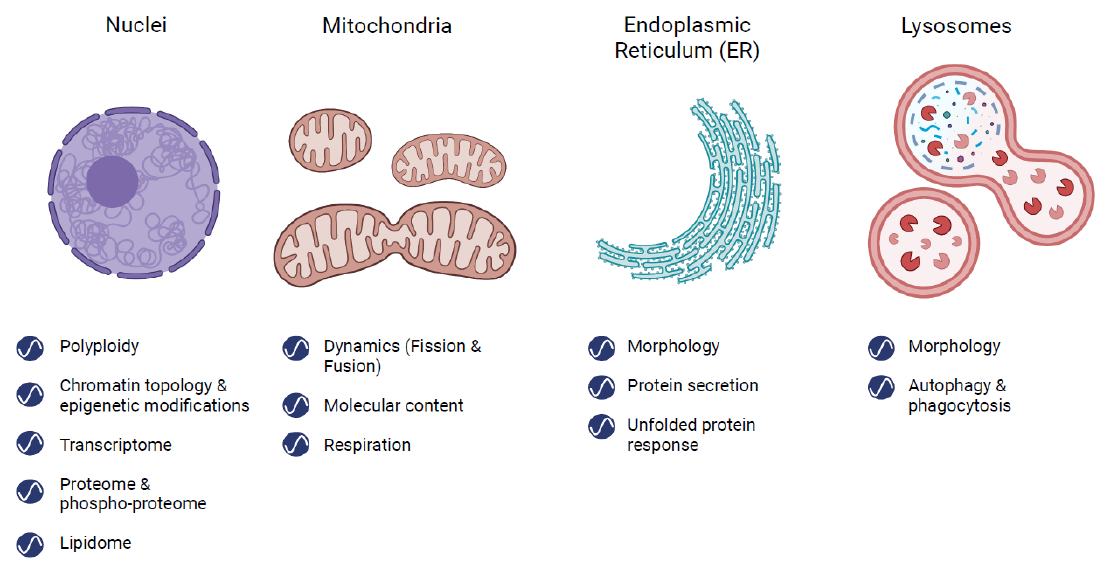
Figure 2. Circadian rhythmicity in subcellular organelles. Illustration of the major organelles discussed in this review: nuclei, mitochondria, endoplasmic reticulum, and lysosomes. Rhythmicity can be observed in the organelles’ structure and function, morphology, and key biochemical processes.